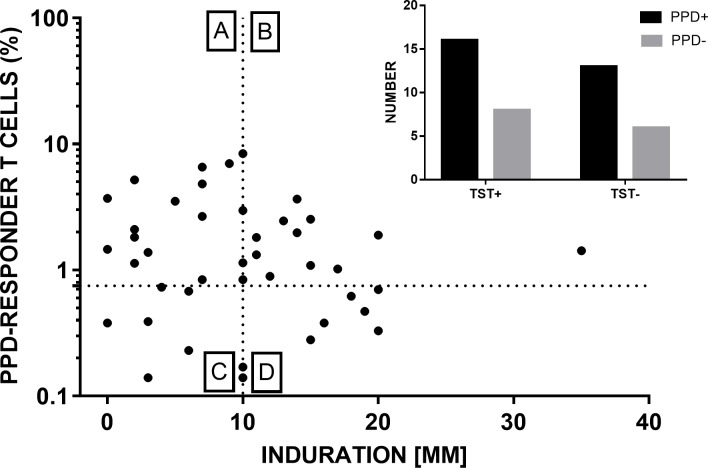
Complementarity of in vivo and in vitro T cell responses to PPD.Cutoffs for positive skin reaction (10 mm induration) and cell proliferation (0.75% responder cells) are shown by dashed lines. Quadrants A-D contain subjects who were [A] negative for in vivo but positive for in vitro response, [B] positive for both responses, [C] negative for both responses, and [D] positive for in vivo but negative for in vitro response. Inset figure (S5 Table) shows absolute numbers in each category.